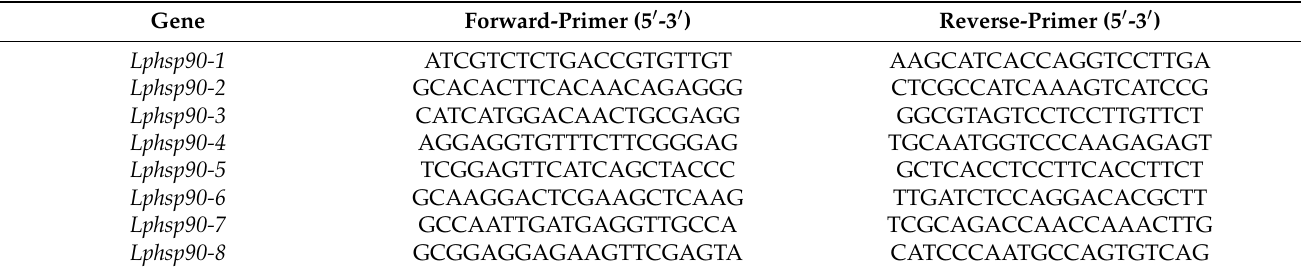
Table 2. Primer information for LpHsp90 genes.